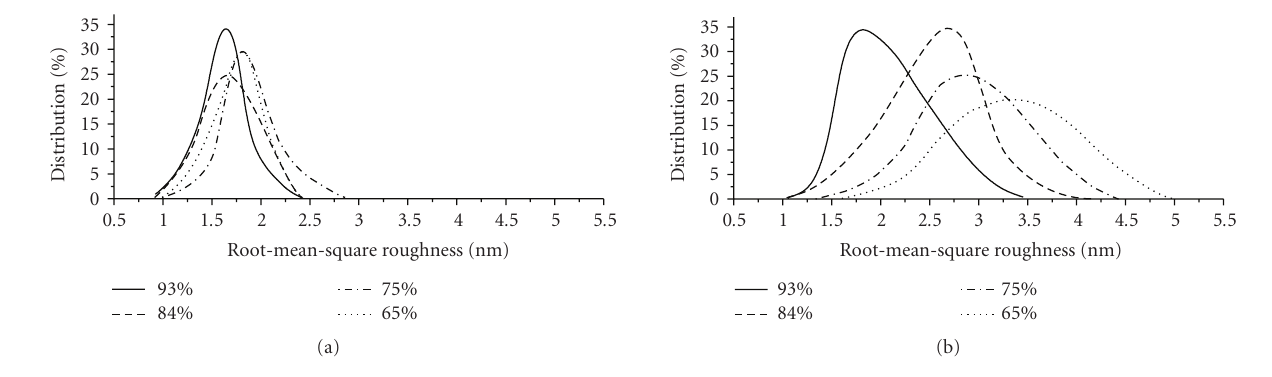
Figure 2: Roughness distribution of B. cereus (a) and E. coli